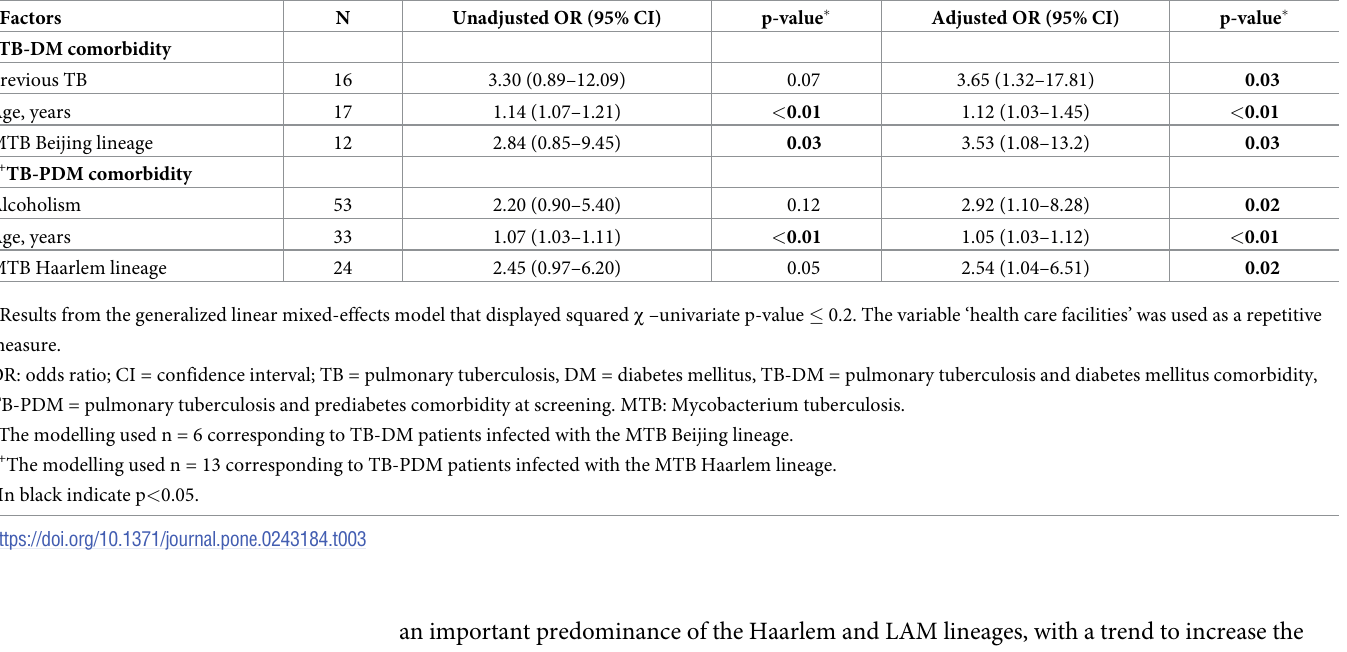
Table 3. Factors associated with TB patients affected with diabetes mellitus or